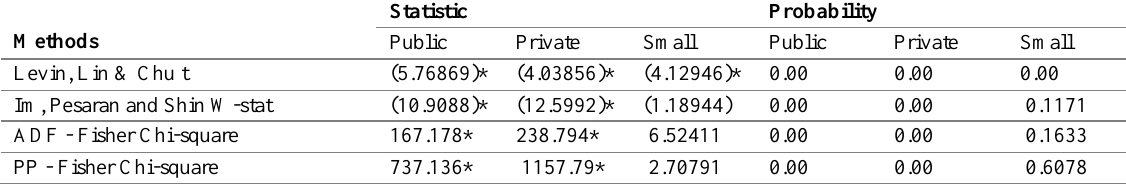
Table 2: Result of Unit Root for Public, Private and Small Finance Banks; Variable- Volume (seasonally adjusted)